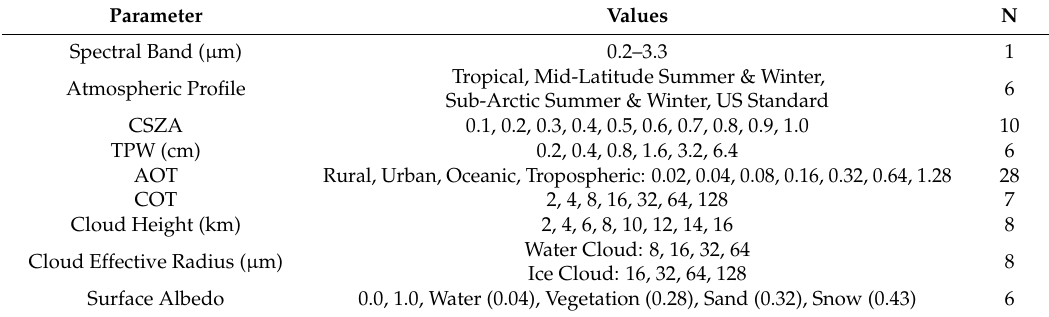
Table 2. Settings of the radiative transfer model for calculating DSR and ASR